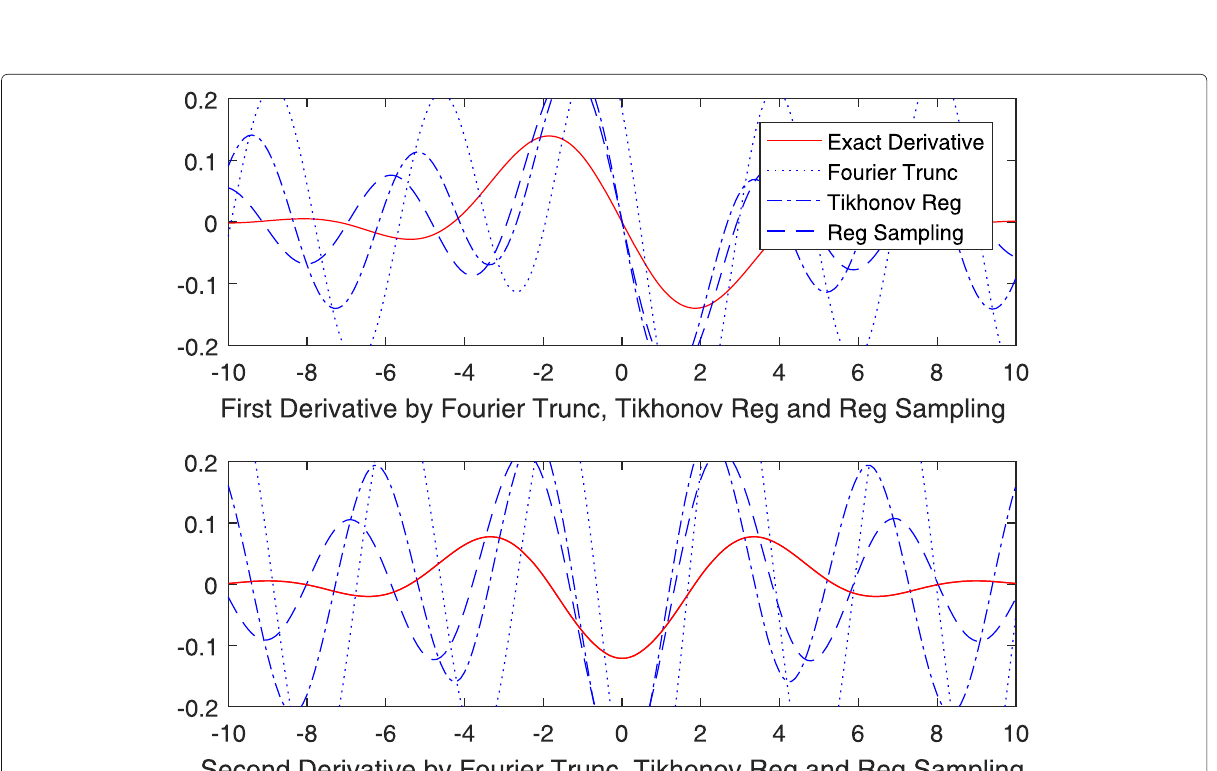
Fig. 7 The simulation results for the bipolar δ noise in Example